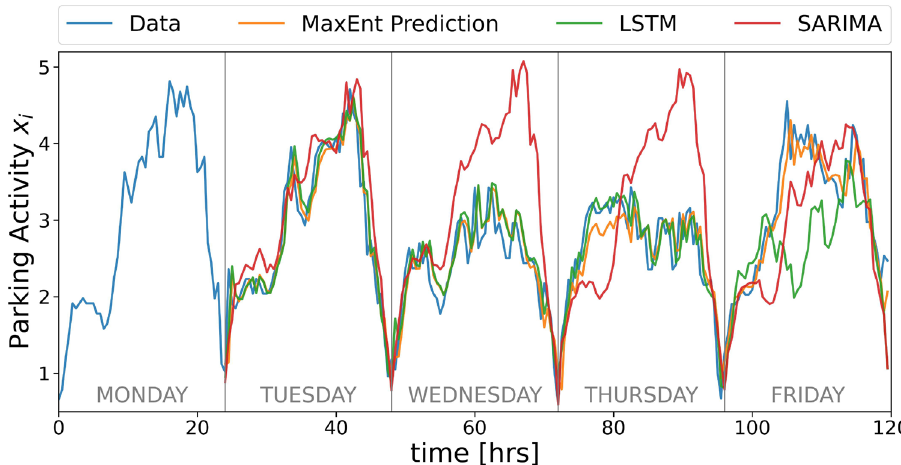
Figure 4. Comparison of the parking activity data (blue) with the prediction of the three models. We can observe that SARIMA models are good predictors of periodicity, but the other models perform better when the change between one period and another is high.